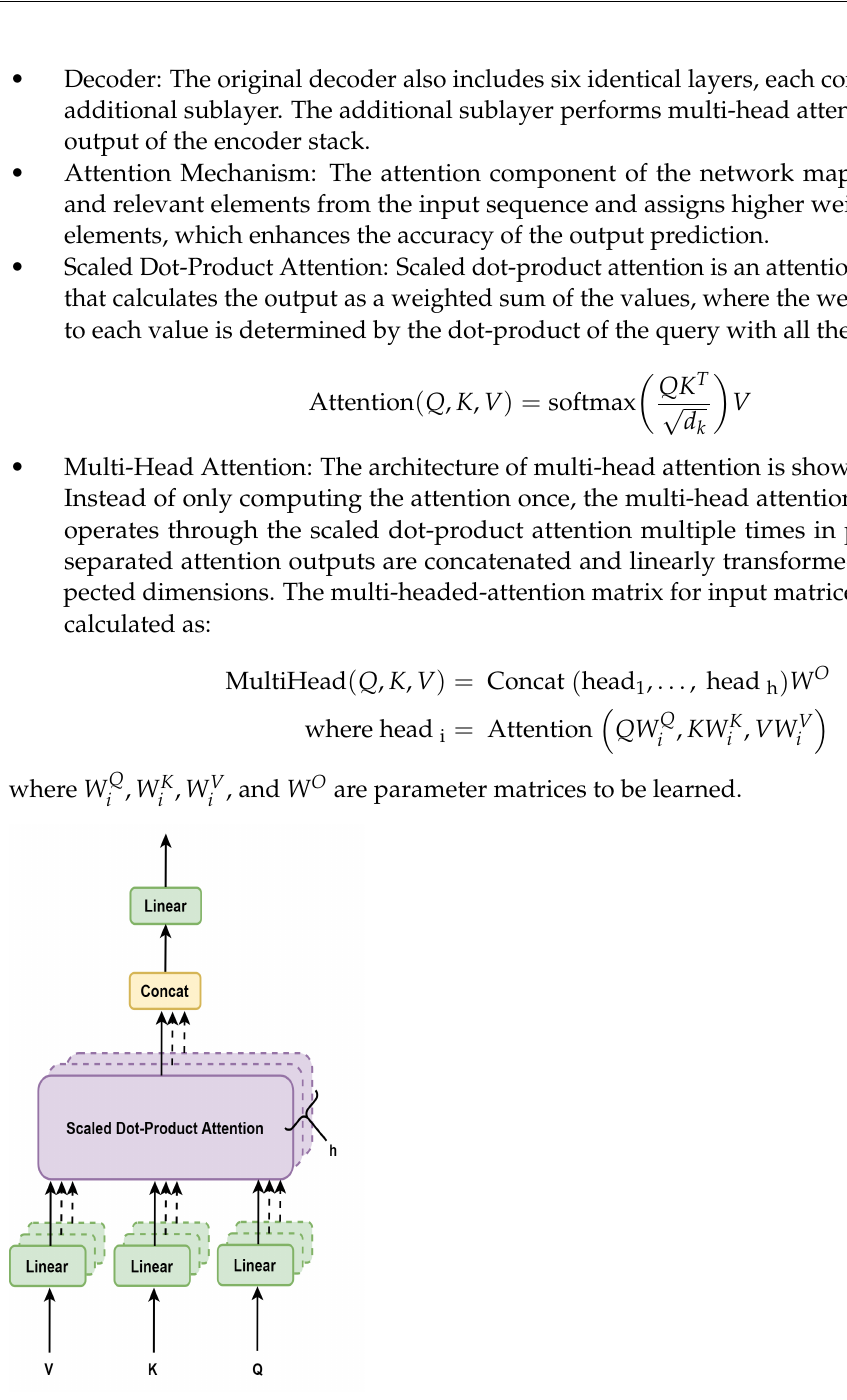
Figure 4. Multi-head attention architecture